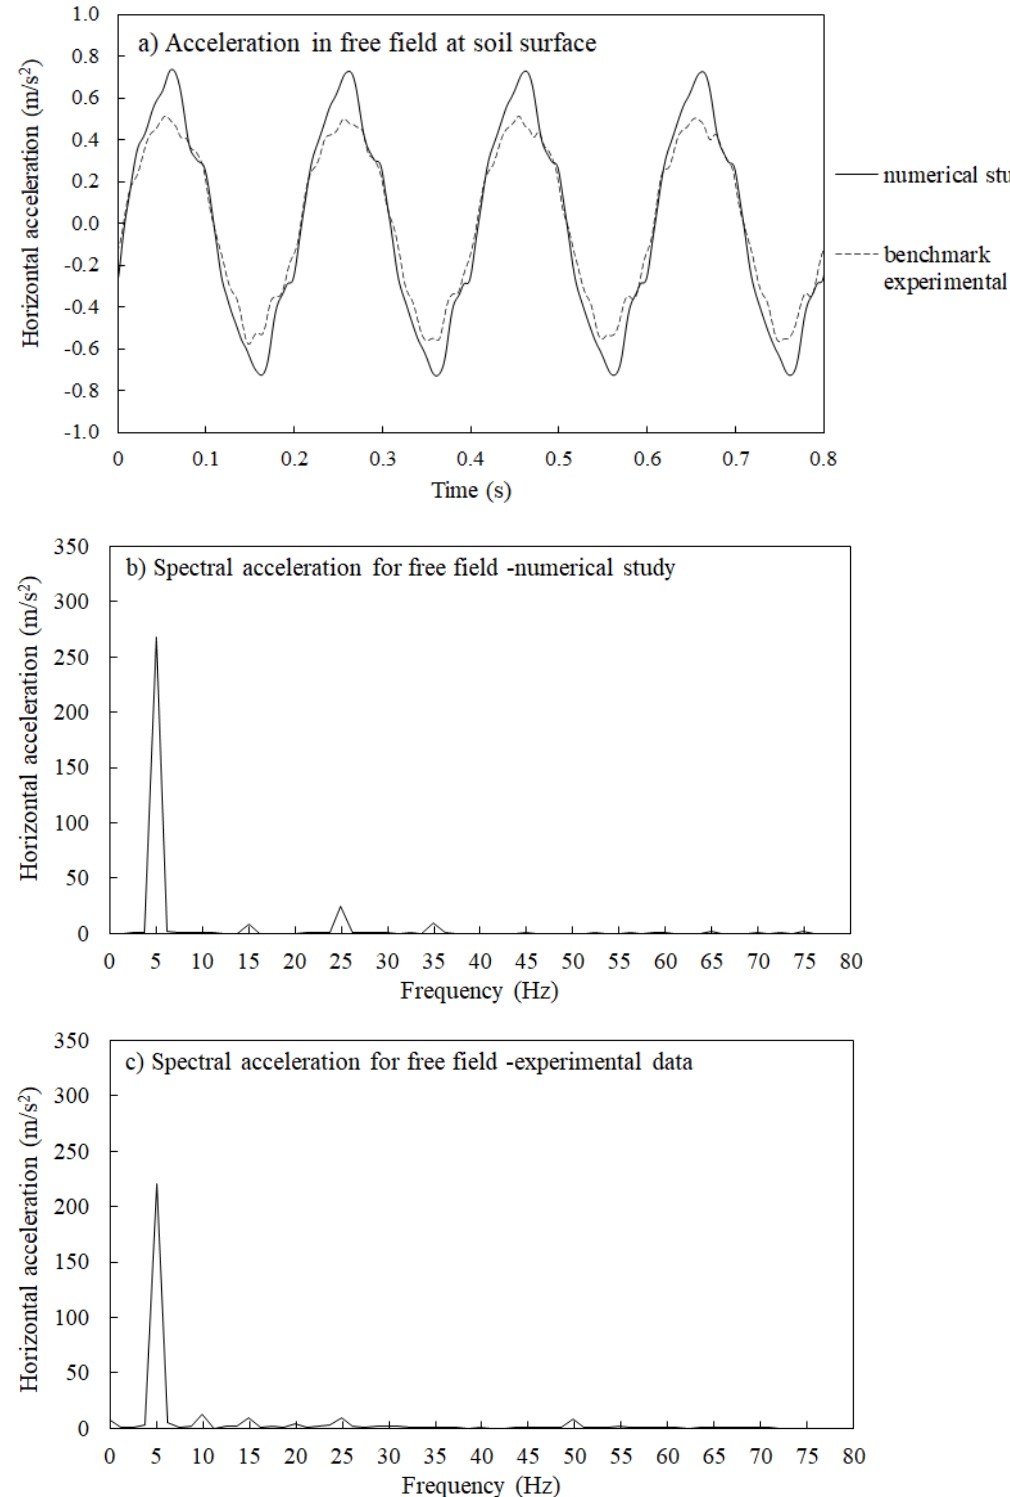
Figure 5: Comparison of the computations and the experimental measurements (Durante, 2015) in free field in the steady-state response: a) horizontal accelerations, b) evaluation of the spectral response of the computed horizontal accelerations, c) evaluation of the spectral response of the horizontal accelerations in the